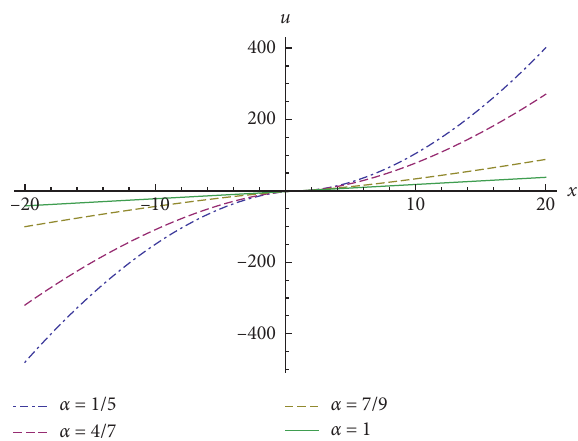
Figure 1: Conformable fractional partial derivatives of u with different